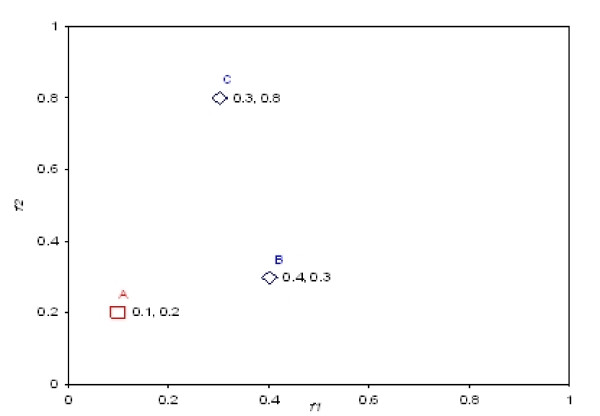
Example of Fuzzy Pareto Dominance